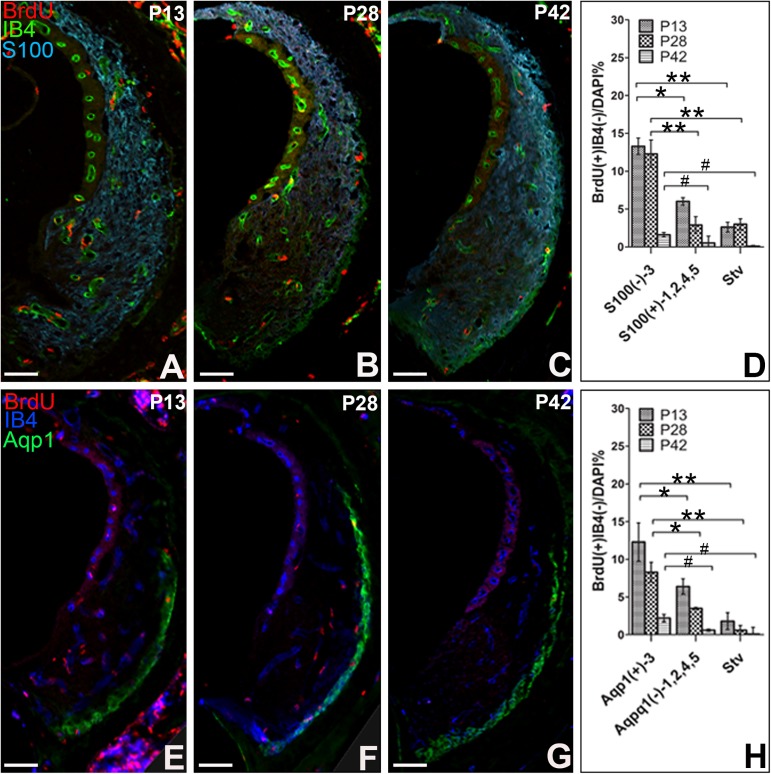
Distribution of BrdU+IB4- fibrocytes at S100 or Aqp1 positive area.Triple immunostaining for BrdU, IB4, S100 (A-C) or Aqp1 (E-F) were performed at P13, P28 and P42 after BrdU administration. The percentages of BrdU+IB4 cells were compared among S100 positive area, S100 negative area and Stv, or among Aqp1 positive area, Aqp1 negative area and Stv. #P > 0.05, **P < 0.01, *P < 0.05. Scar bar = 100μm.